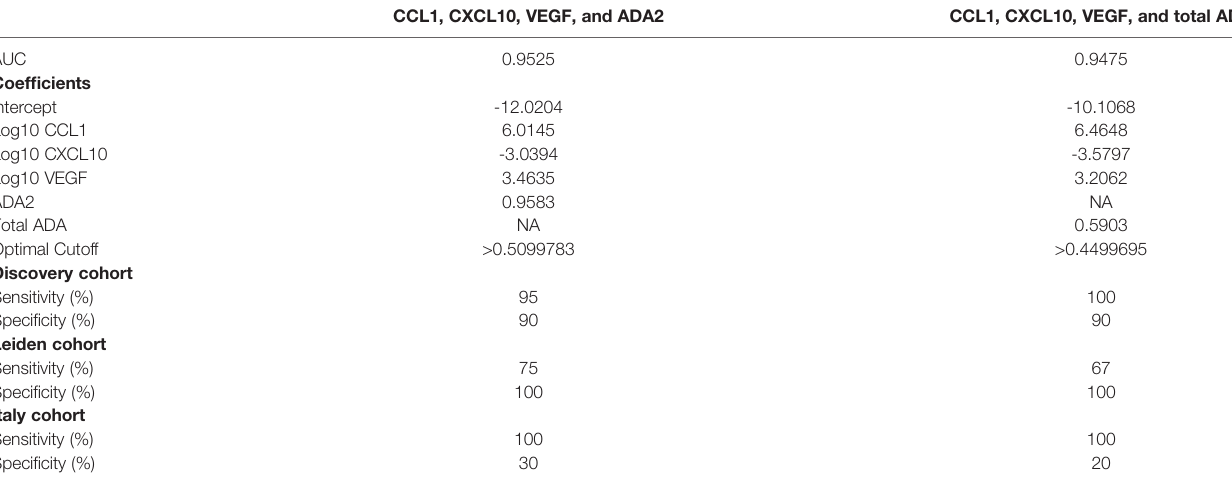
TABLE 3 | Evaluation biomarker signature (CCL1, CXCL10, VEGF, and ADA2 or total ADA) in distinguishing ATB from untreated